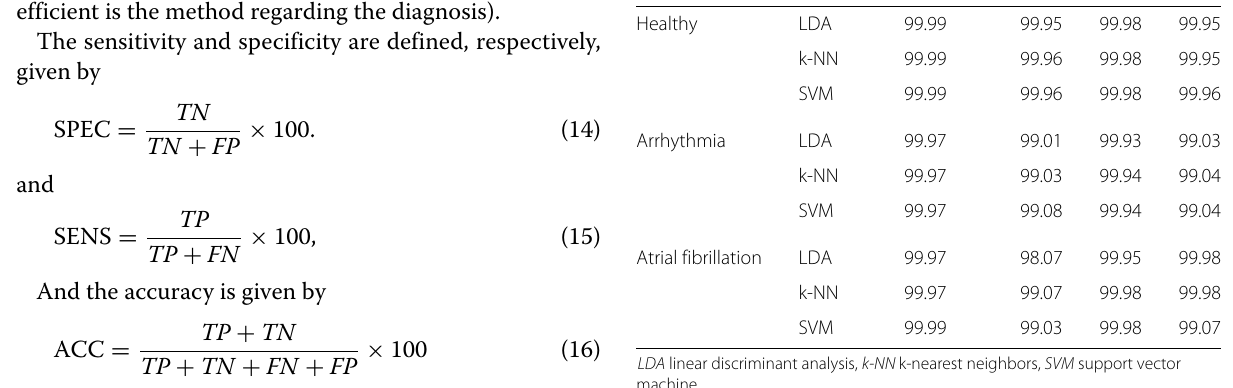
Table 3 shows the average accuracy of the classifiers using variance, skewness, and kurtosis in the diagnosis of arrhythmia and AF. The results in this study are eval- uated using 10-fold cross-validation, that is, definitive classification is the mean of the metrics (specificity, sensi- tivity, and accuracy) for ten different sets of training and